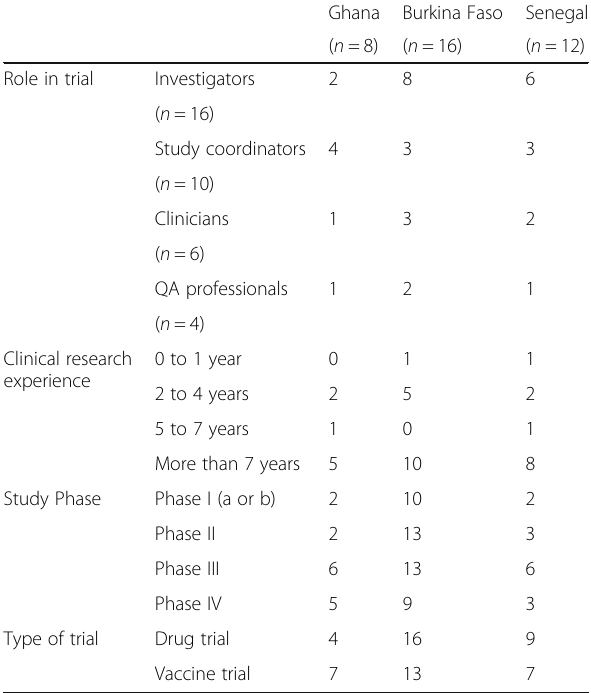
Table 2 Role and experience of interviewees Ghana Burkina Faso